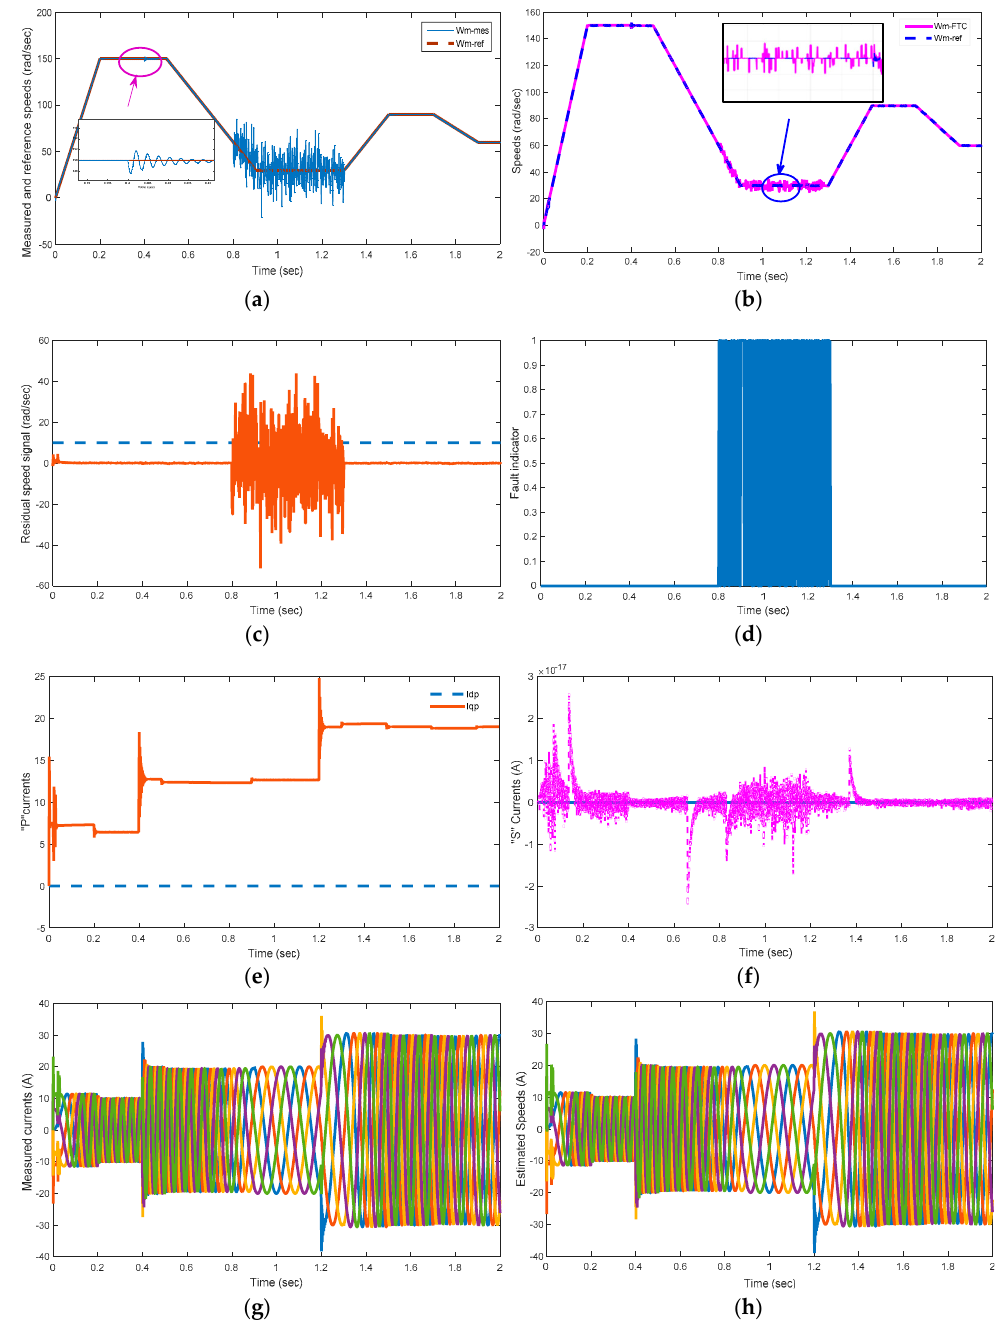
Figure 7. 5P-PMSM performance with speed sensor noise fault: ( a ) speed responses with speed sensor fault occurrence at t = 0.8 s; ( b ) speed responses with FTC strategy; ( c ) fault noise and threshold ( d ) fault indicator; ( e ) primary current responses; ( f ) secondary current response; ( g ) measured stator currents; ( h ) estimated stator currents.